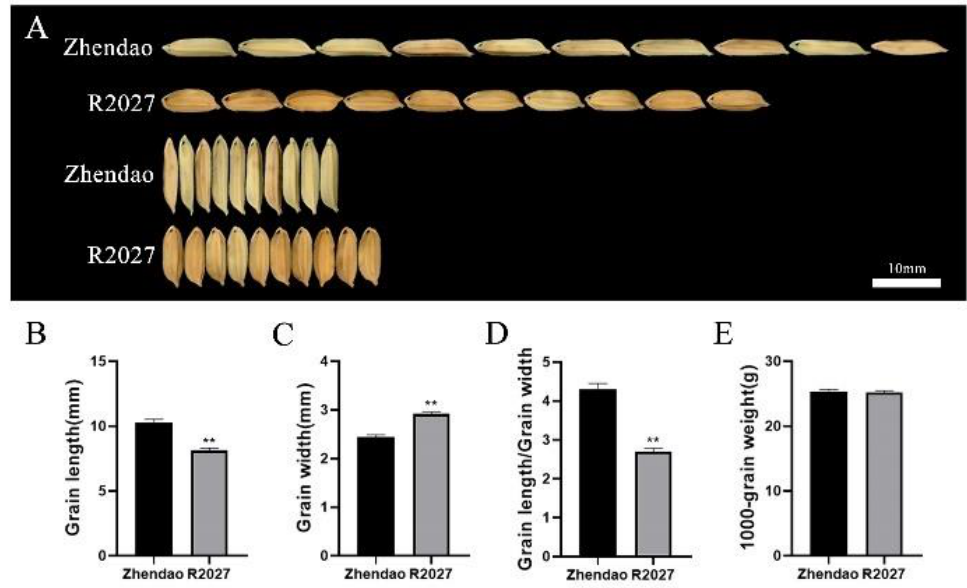
Figure 1. Grain size comparison between Zhendao and R2027. ( A ) Length and width comparison of Zhendao and R2027. Scale bar, 10 mm. ( B – E ) Grain length ( A ), grain width ( B ), grain length/grain width ( D ) and 1000-grain weight ( E ) of Zhendao and R2027. Error bars, SD of ten biological replicates. ** p < 0.01 compared with WT (Zhendao), Student’s t -test.